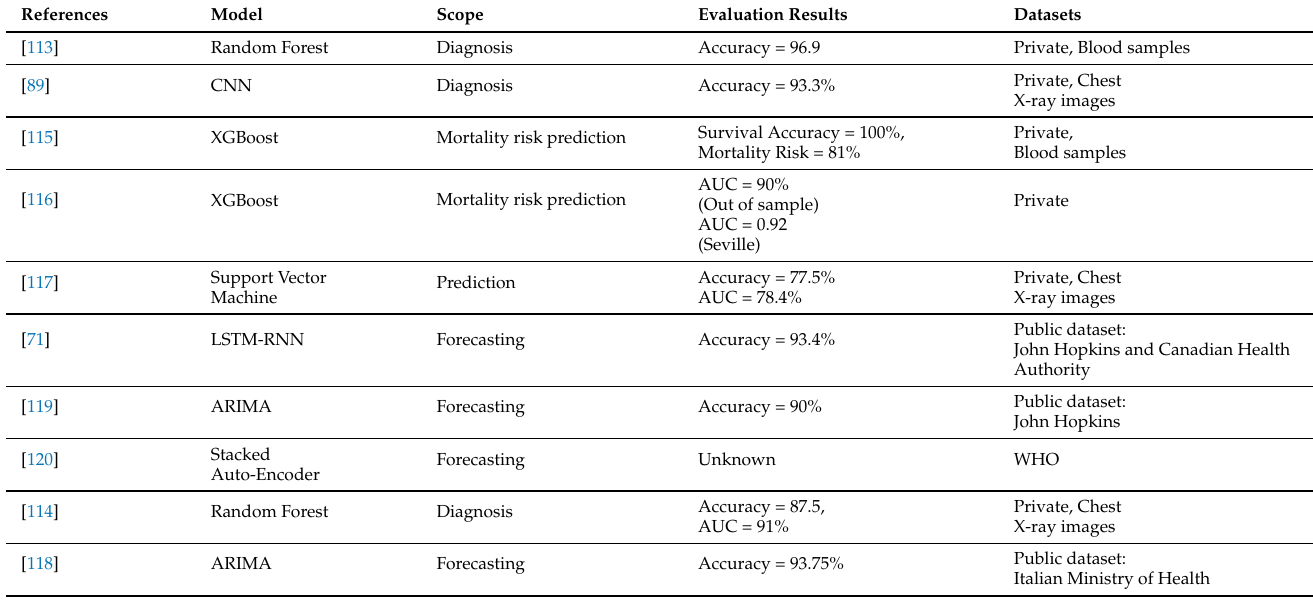
Table 4. A summary of literature review of articles for COVID-19 diagnosis and